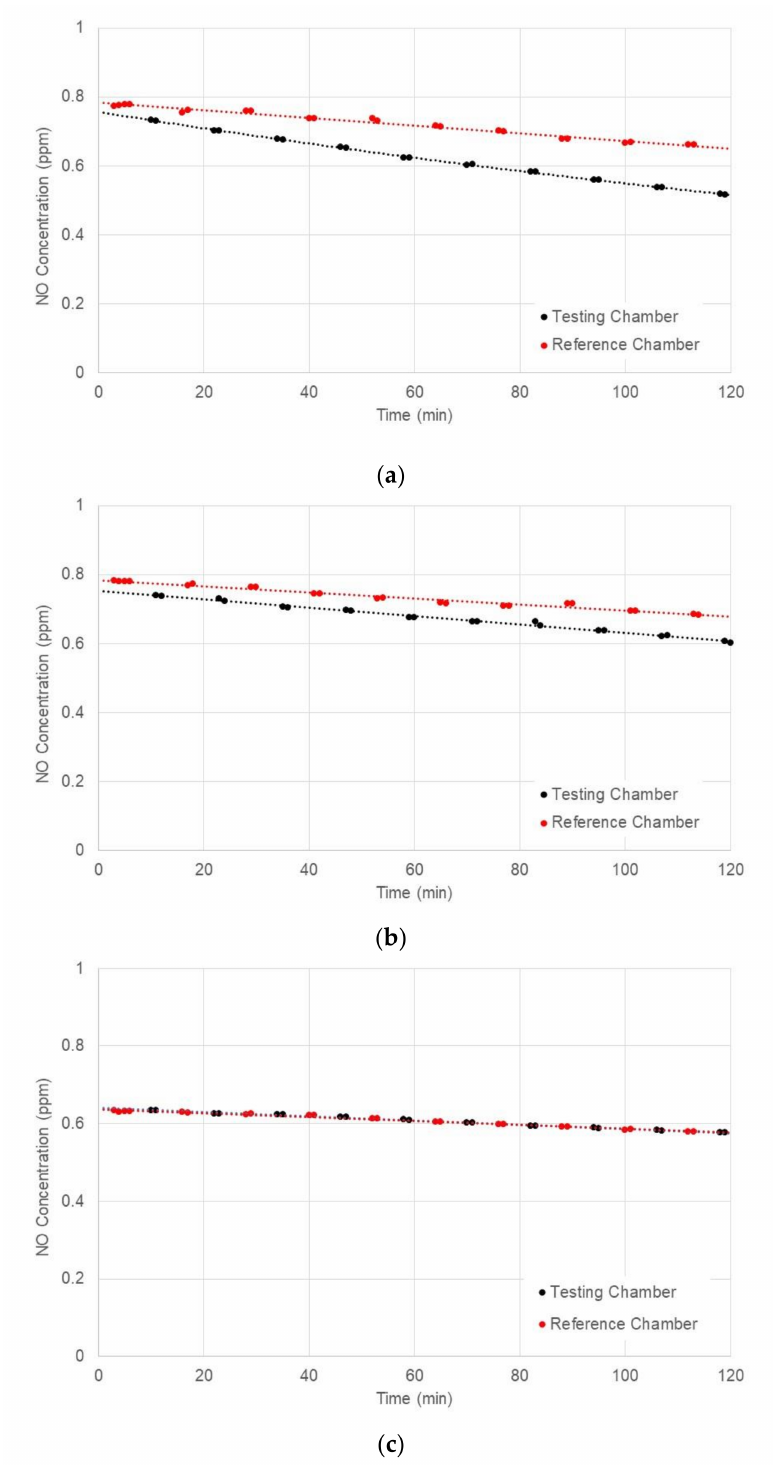
Figure 12. Comparison of NO concentrations measured in testing and reference chambers at different levels of solar radiation: ( a ) Average Solar Radiation = 564 W/m 2 ; ( b ) Average Solar Radiation = 358 W/m 2 ; and ( c ) Average Solar Radiation = 67 W/m 2